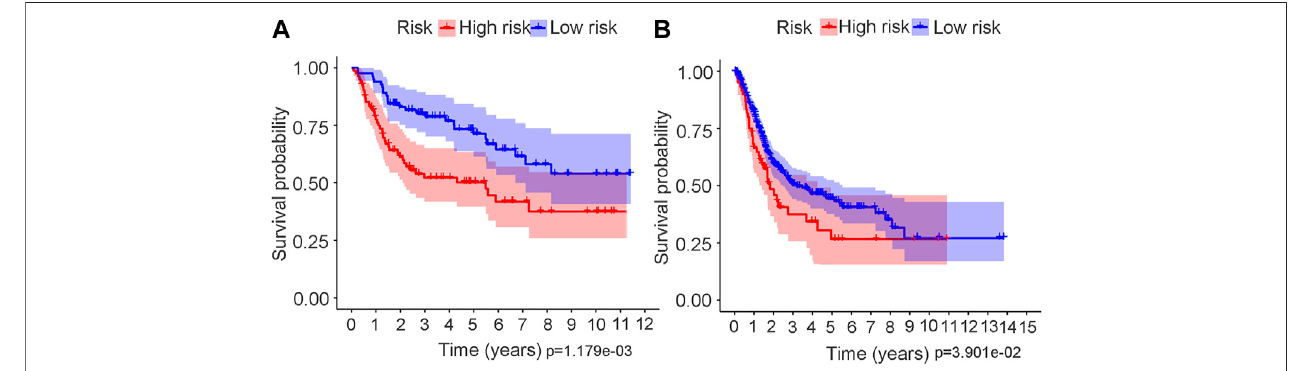
FIGURE 7 | The results of univariate and multivariate cox regression analysis in GEO cohort. (A) The univariate cox regression analysis in GEO cohort. (B) The multivariate cox regression analysis in GEO cohort.